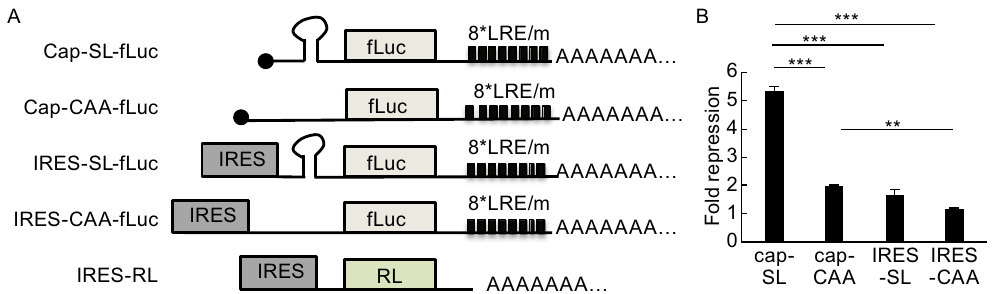
Figure 1. The cap structure of target mRNA is required for optimal miRNA-mediated gene silencing. (A) Schematic representation of the reporter mRNAs. Eight tandem Let-7a response elements (LRE) or mutants (REm) were cloned downstream of the coding sequence of fi re fl y luciferase (fLuc). A stem-loop (SL) structured fragment or a fragment containing (CAA) 18 was inserted into the 5 ′ UTR of the reporters indicated. (B) Reporter mRNAs were transfected into HeLa cells. A control reporter expressing renilla luciferase (RL) driven by EMCV IRES was included. At 24 h postinfection, luciferase activities were measured and fi re fl y luciferase activity was normalized with renilla luciferase activity. Data presented are means ± SD of three independent experiments. The P value is determined by two-tailed Student ’ s t test. ns, nonsigni fi cant. ** P < 0.01; *** P <